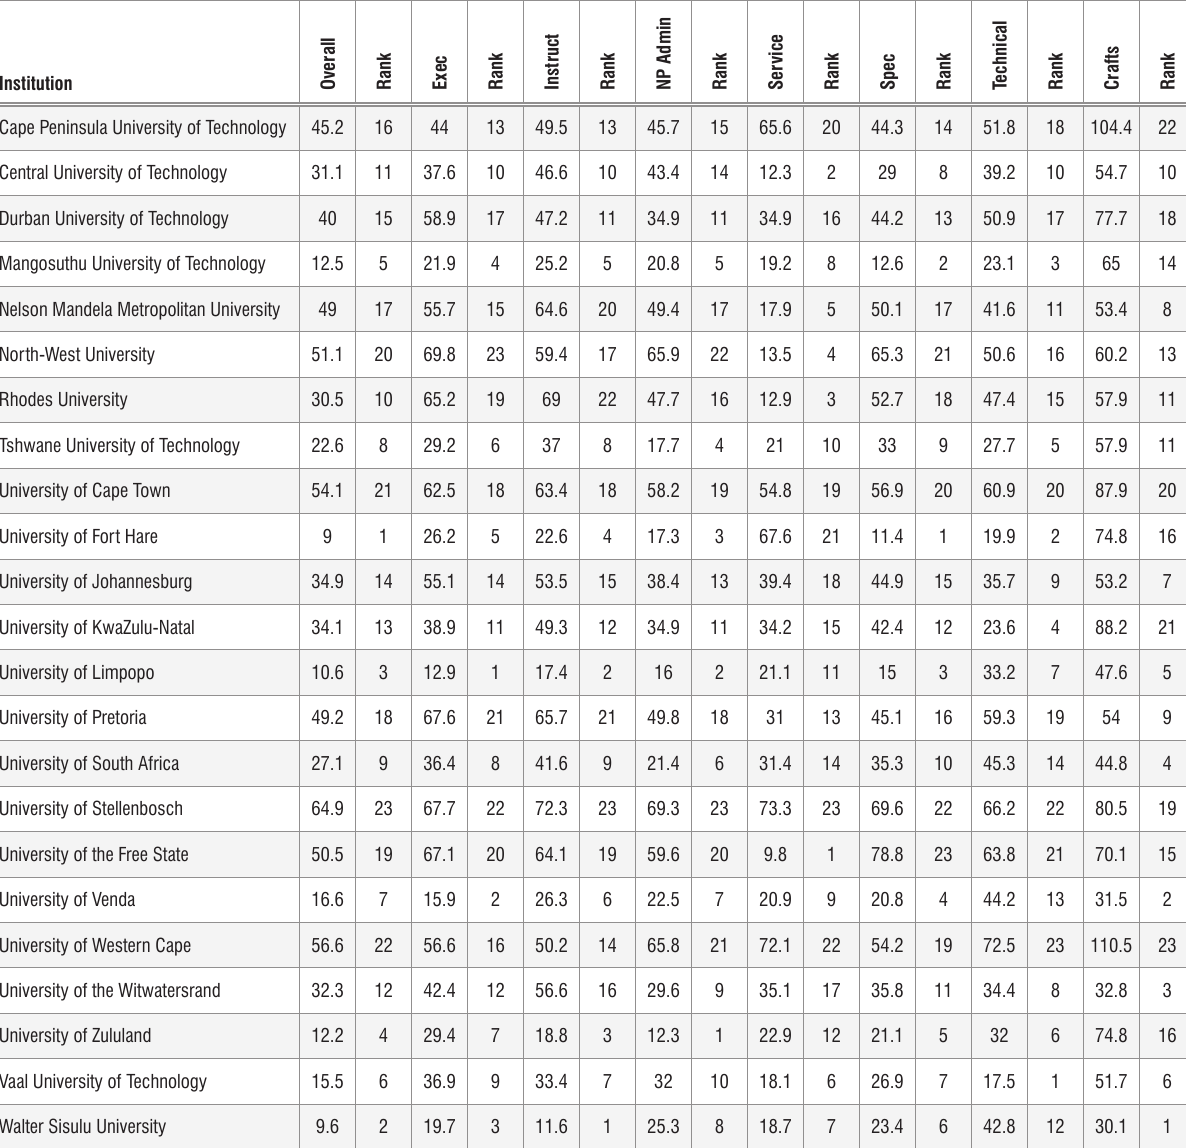
Equity Indices for staff categories at universities in South Africa together with institutional rankings within each category ( n =8)